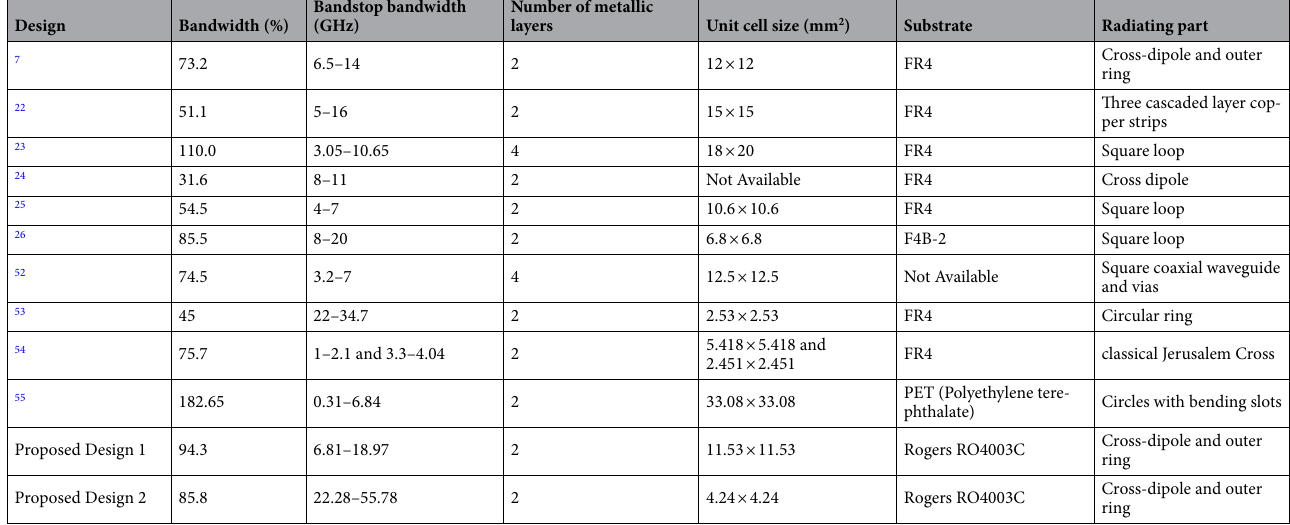
Table 1. Proposed FSS design versus state-of-the-art literature